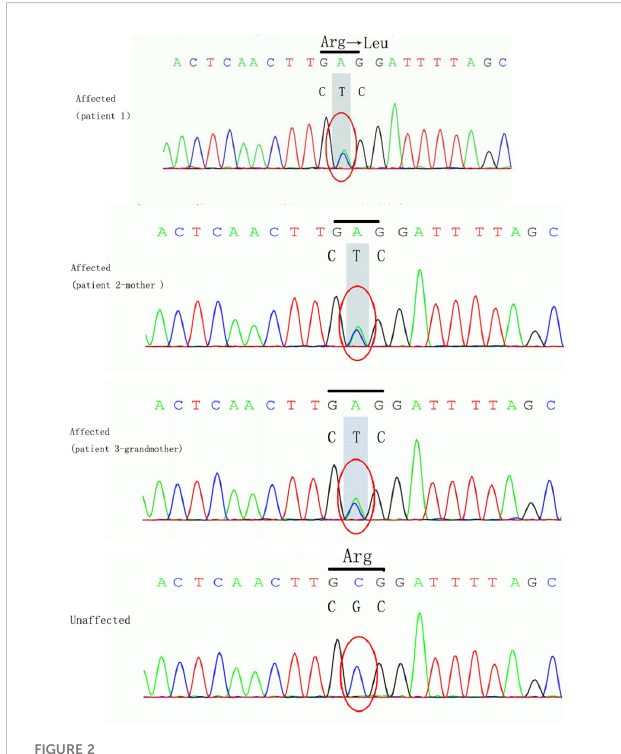
FIGURE 3 FRMD7 mutations in this family. The family (20 members) included four affected females and two